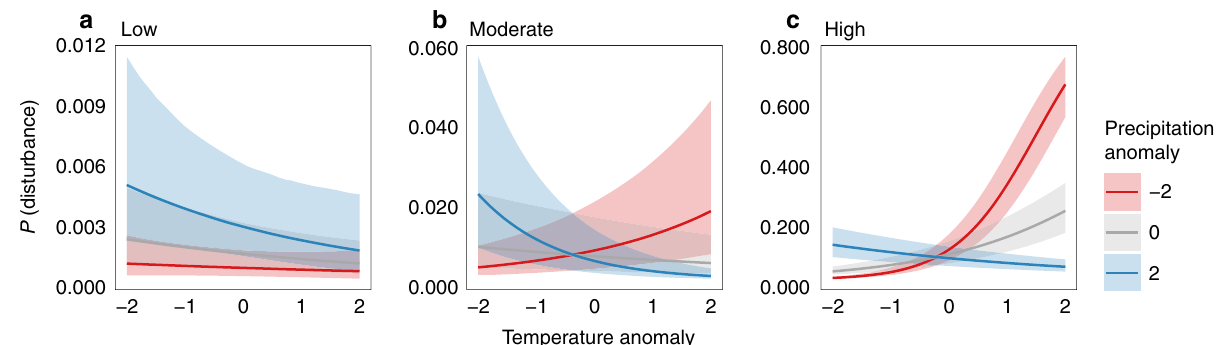
Fig. 4 Predicted response of disturbance probability to temperature anomaly, modulated by precipitation anomaly. a – c The climate sensitivity of disturbances separately for three global clusters of disturbance activity (cf. Table 1). Anomaly values are units of standard deviation with zero indicating the long-term mean. Y -axes are scaled differently across the three panels for clarity of presentation. Prediction uncertainty was estimated from 9999 model simulations, with the lower and upper limit representing the 2.5 and 97.5% quantile of all simulations. We note that prediction intervals include both parameter and model uncertainty, and overlapping prediction intervals can occur despite signi fi cant differences in parameter values. For parameter estimates and standard errors, see Supplementary Table 4. The number of experimental replicates equals the number of study sites per cluster (Low: